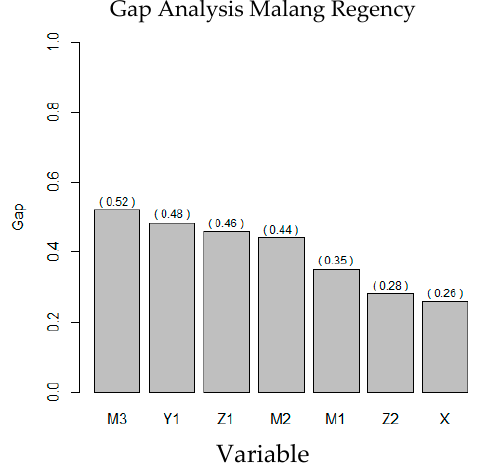
Figure A2. Bar Diagram of Gap Analysis of Malang Regency.